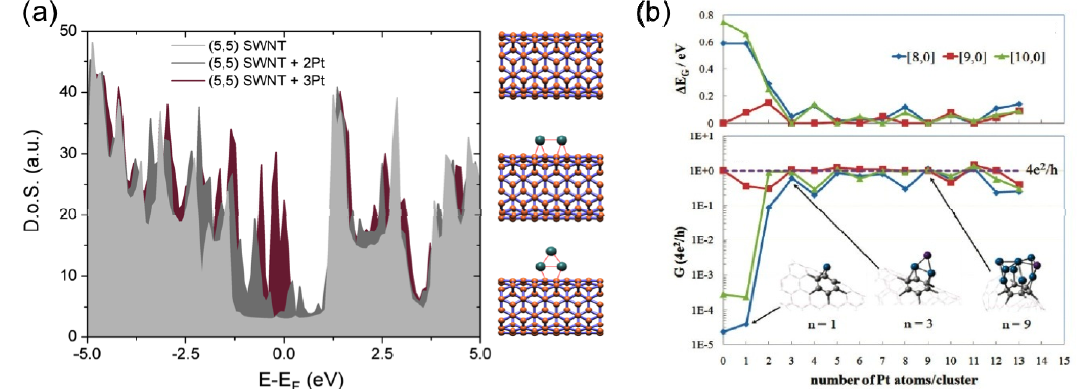
Figure 9. ( a ) Effect of platinum atom decoration on the (top) band-gap and (bottom) conductance of a metallic (9,0) and two semiconducting (8,0) and (10,0) SWNTs. For number of atoms > 3, all semiconducting SWNTs become metallic and their conductance approach the quantum limit of 4 e 2 /h. Metallic tube remains metallic; ( b ) Cyclic high-bias treatment (HBT) treatment produced a Pt-nanoclusters decoration of the outer surface of the tube along with a conductance enhancement. (Inset) Platinum-decorated multi wall carbon nanotubes upon HBT